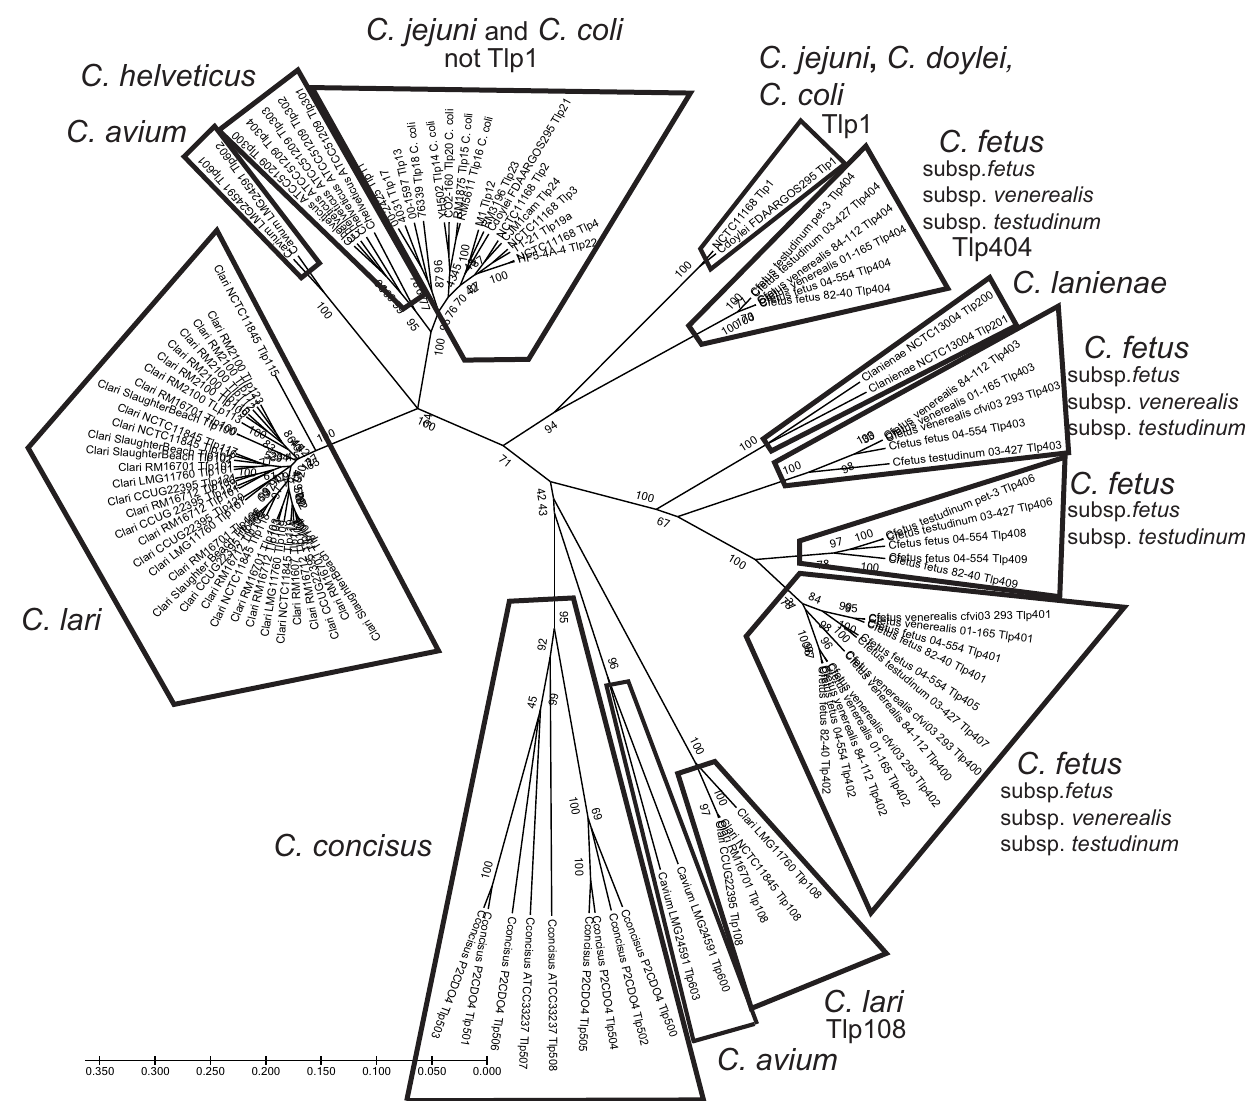
Fig 1. UPGMA dendrogram of Campylobacter Tlps. For the Cj/Cc group only one protein sequence was chosen to represent the Tlp type. Because fewer closed and high quality draft sequences were available for the other species, all Tlps associated with these species were included in the analysis.